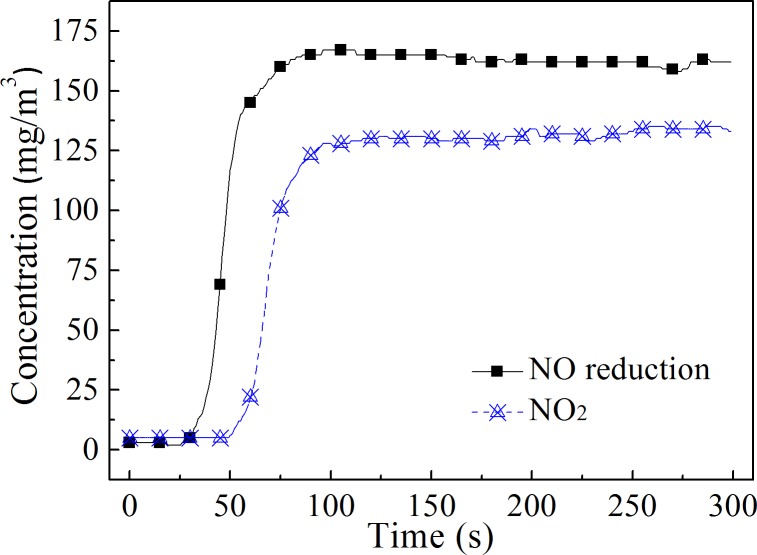
The change in NO2 concentration.The temperature in the reactor was 400°C.